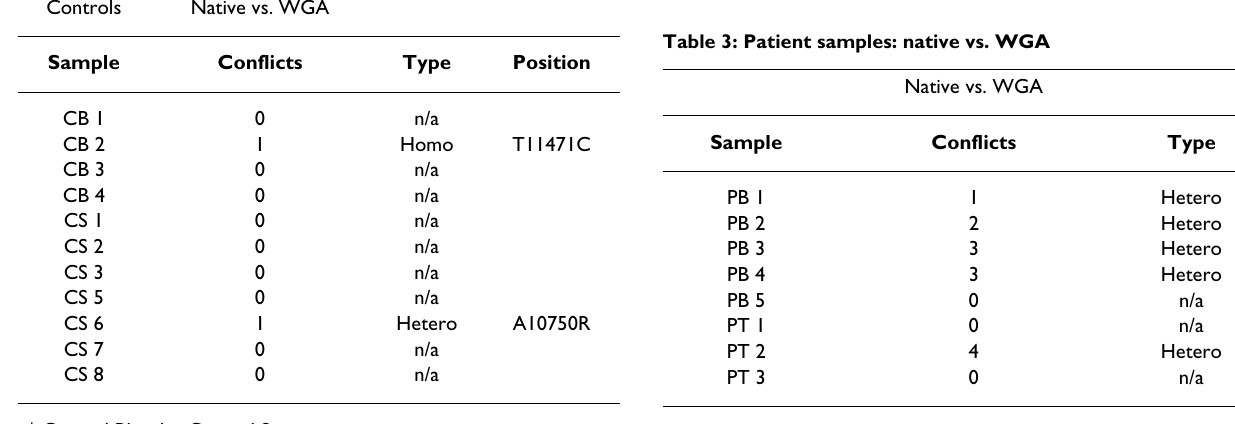
Table 3: Patient samples: native vs. WGA